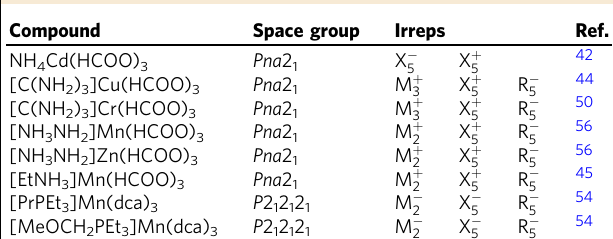
Table 2 A summary of known polar molecular perovskites, their crystal symmetries, and the corresponding